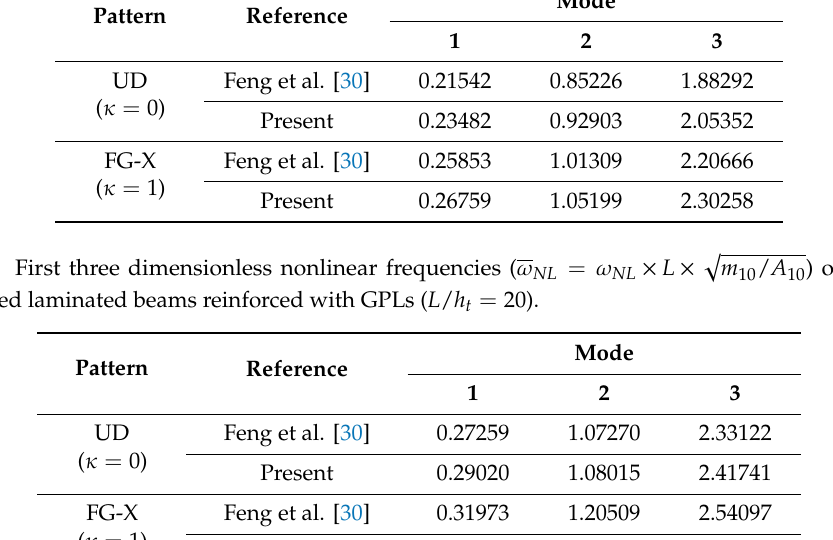
Table 1. First three dimensionless natural frequencies ( ω L = ω L × L × laminated beams reinforced with GPLs ( L / h t = 20).